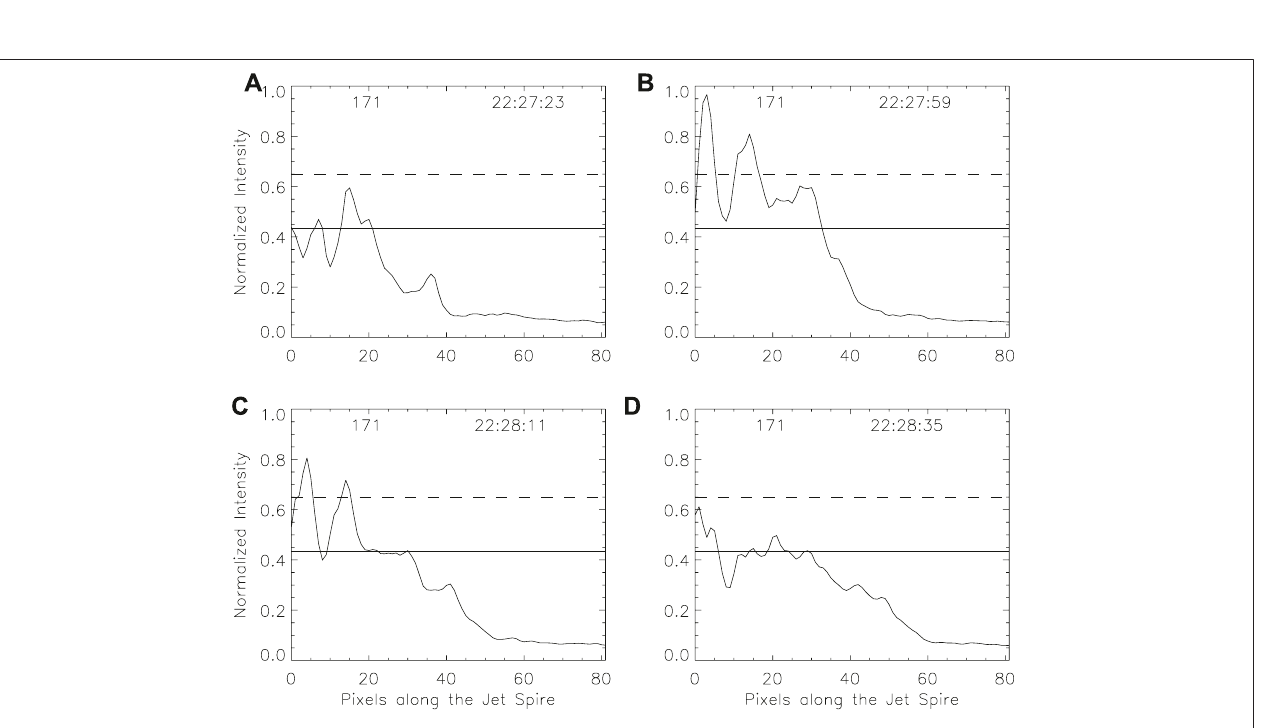
FIGURE 3 | Intensity pro fi les along the spine of the jet in Figure 2A . We select the region which is marked with a white rectangle in Figure 2A to calculate the total intensity of the jet spine. The different curve indicates the normalized intensity along the jet spine at different moments, 22:27:23, 22:27:59, 22:28:11, 22:28:35,